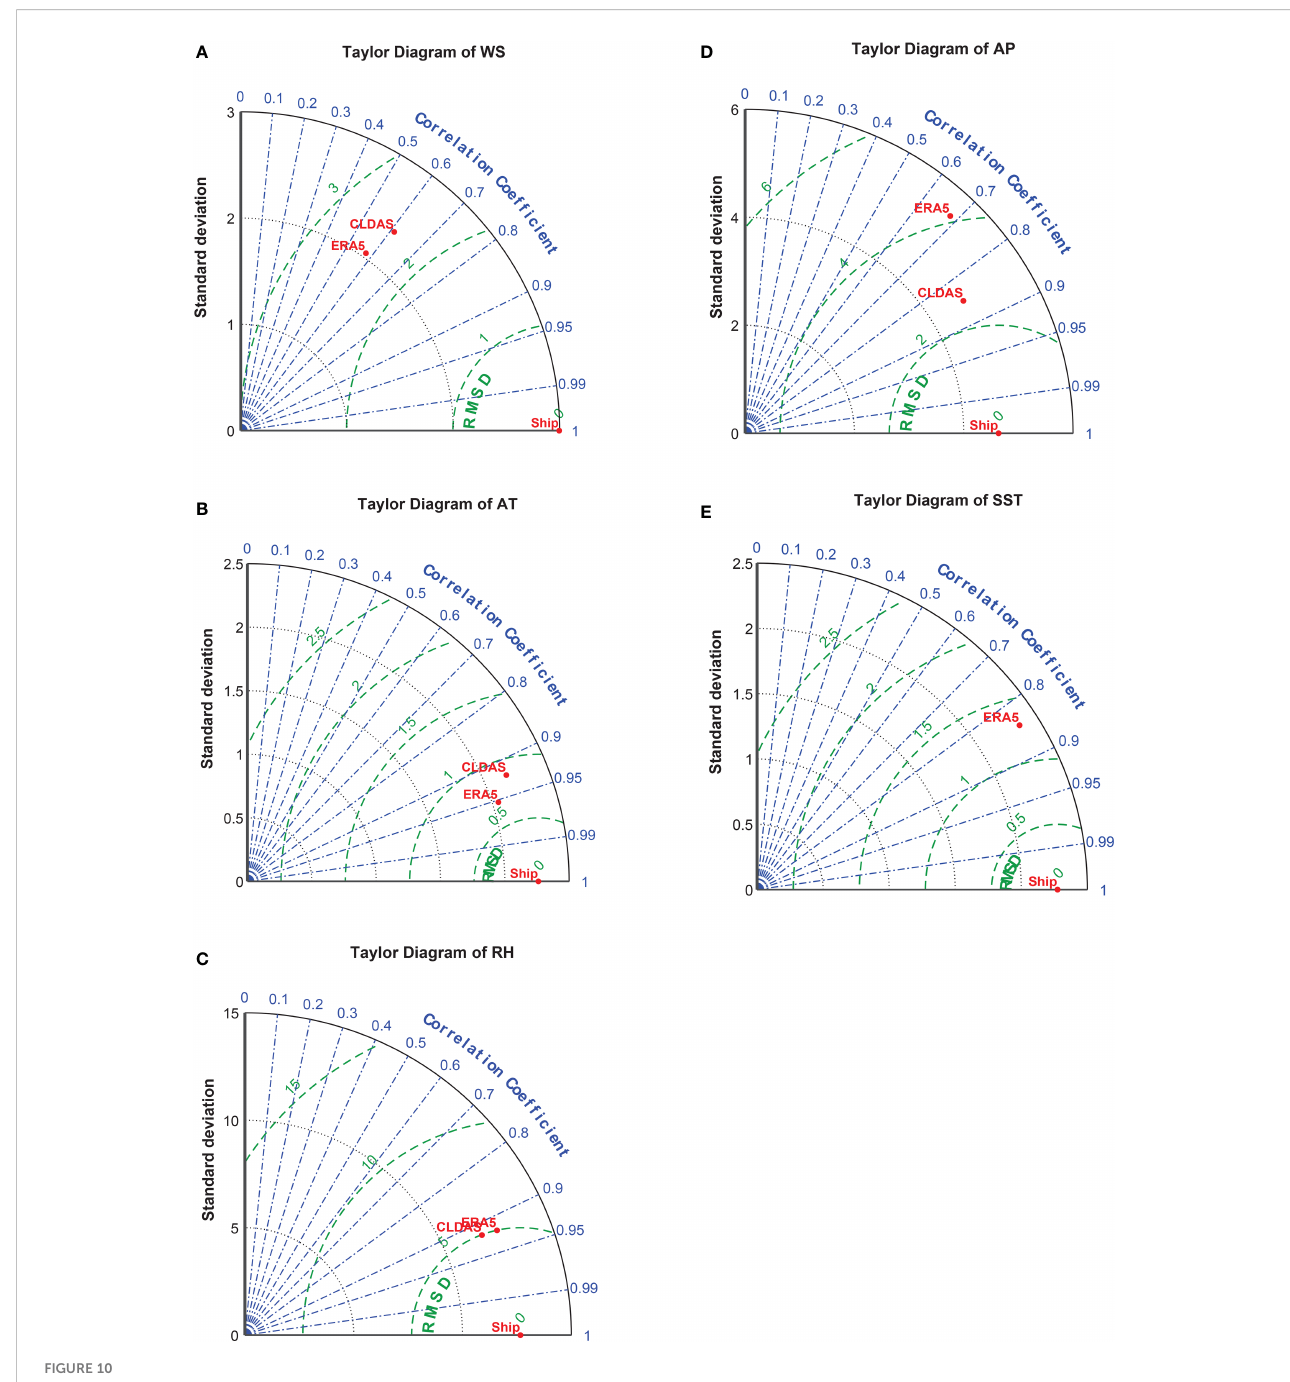
FIGURE 10 Accuracy of the reanalysis data: (A) WS; (B) AT; (C) RH; (D) AP; (E)